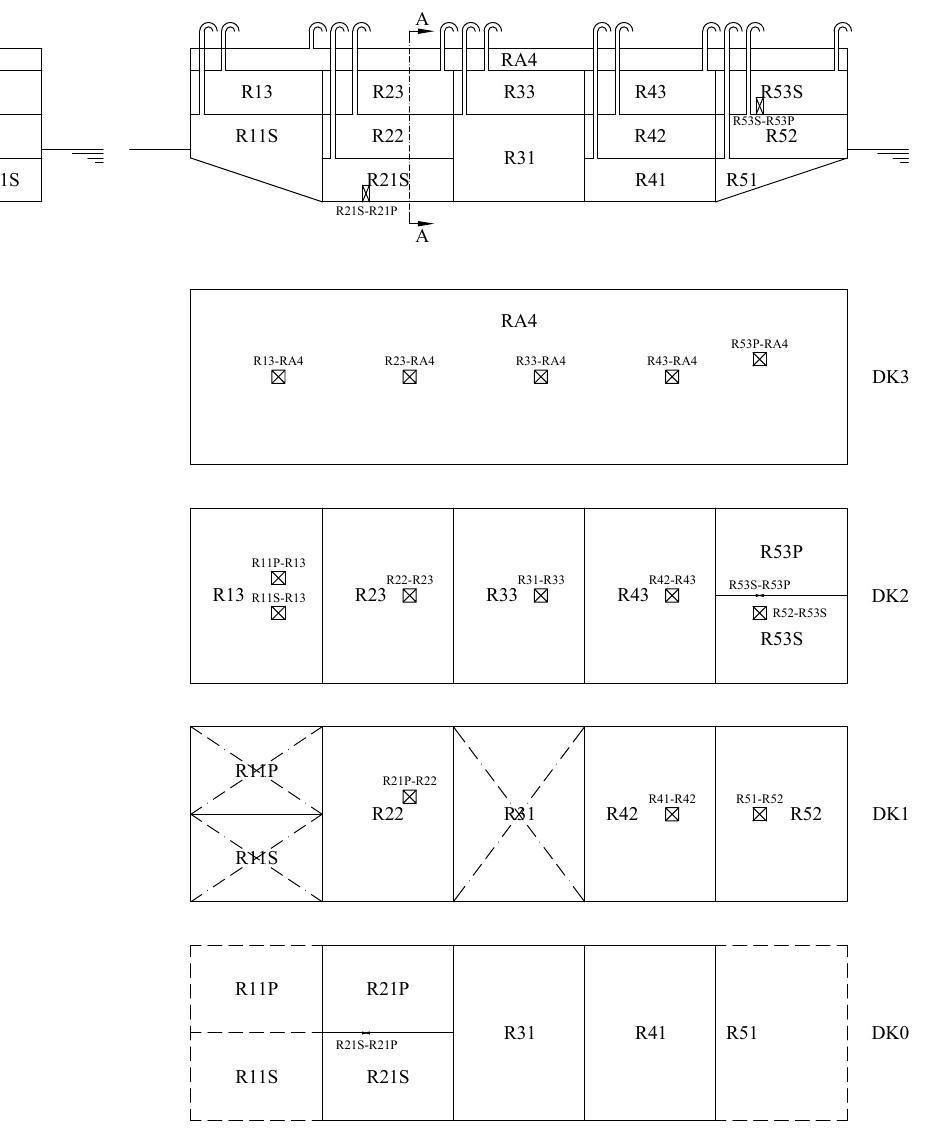
Figure 5. General arrangement of the test